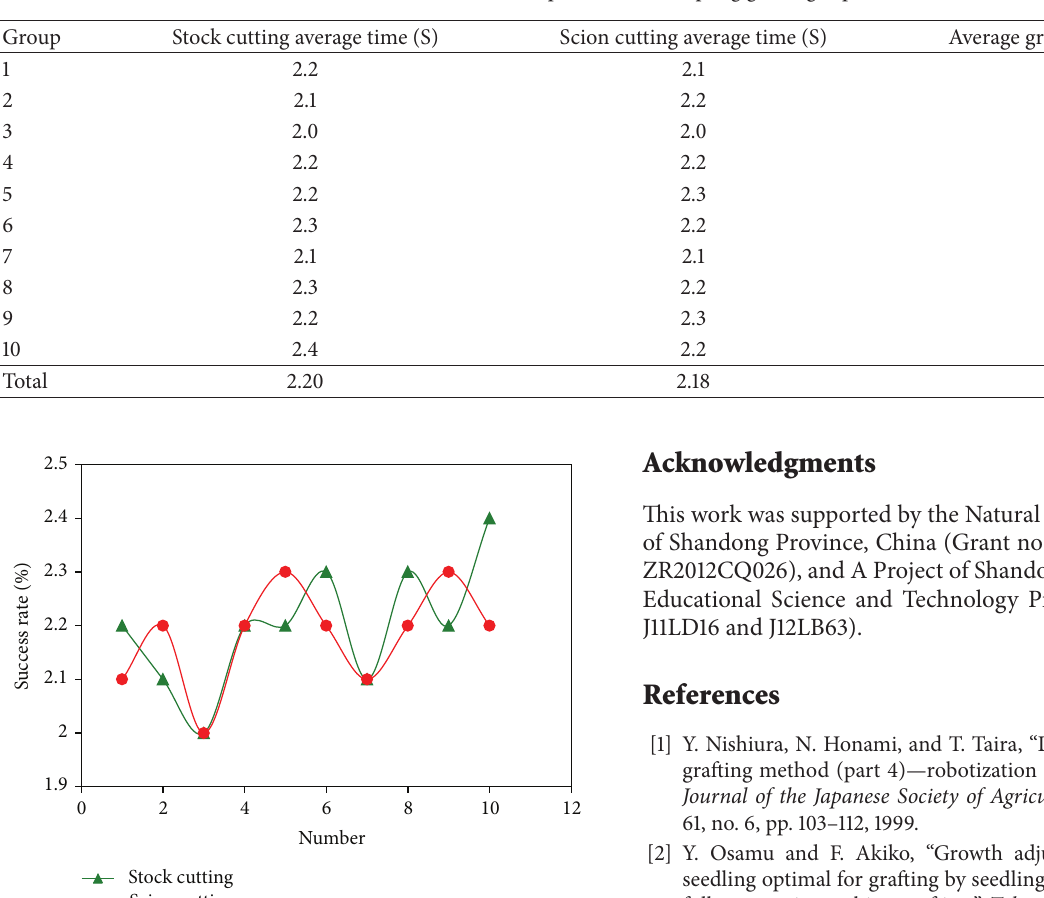
Table 2: Results of consumption time for sapling grafting experiments.